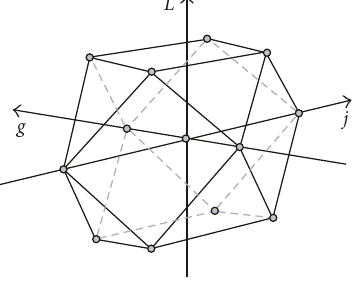
Figure 1: In the OSA color system, color samples are arranged in a regular rhombohedral lattice in which each point is surrounded by twelve neighboring colors, all perceptually equidistant from the central one.